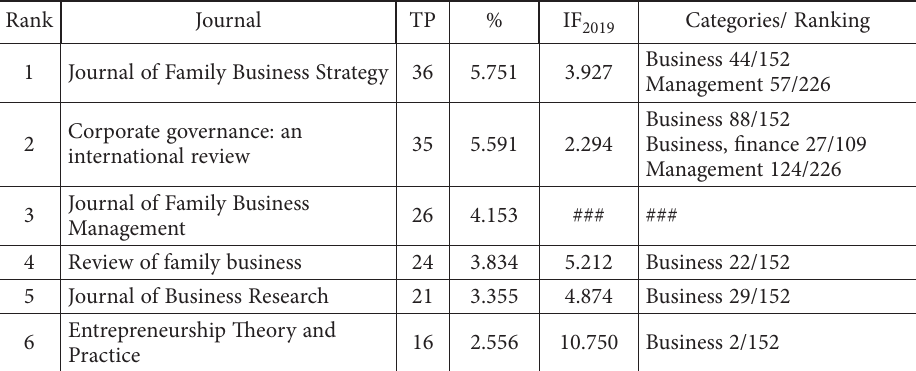
Table A1. The top 10 influential